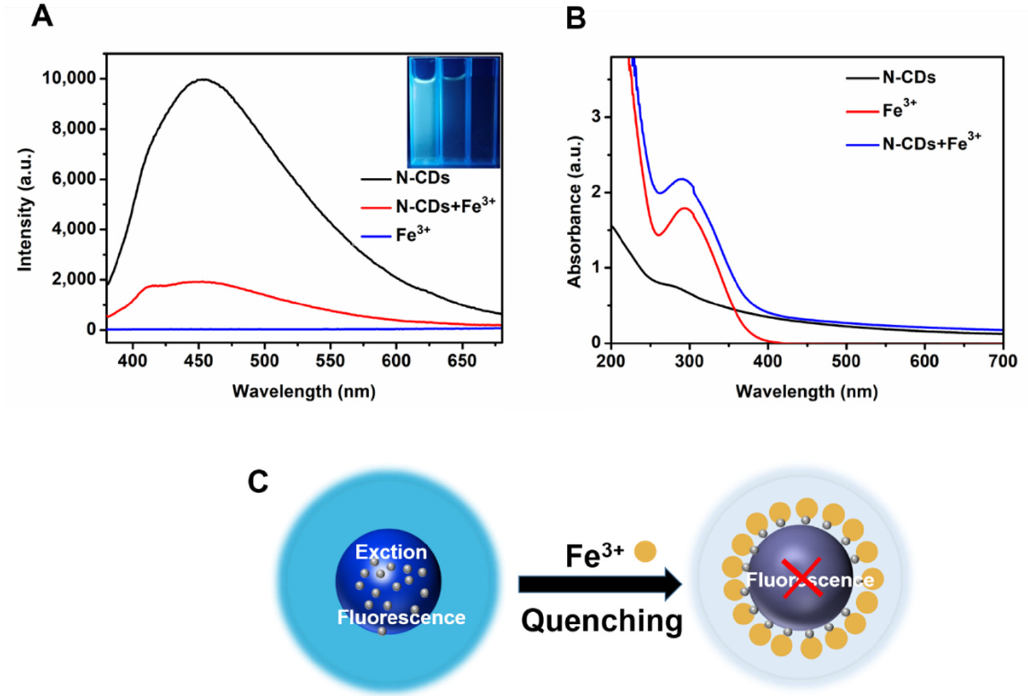
Figure 4. ( A ) Fluorescence spectra of N − CDs in the absence and presence of 1 mM Fe 3+ at the excitation of 360 nm; insets show the photographs of the N − CD solutions in the absence and presence of Fe 3+ under UV light (365 nm); ( B )Change in UV–vis absorption spectra of N − CDs upon addition of Fe 3+ ; ( C ) Speculation on the fluorescence quenching mechanism of N − CDs by Fe 3+ .